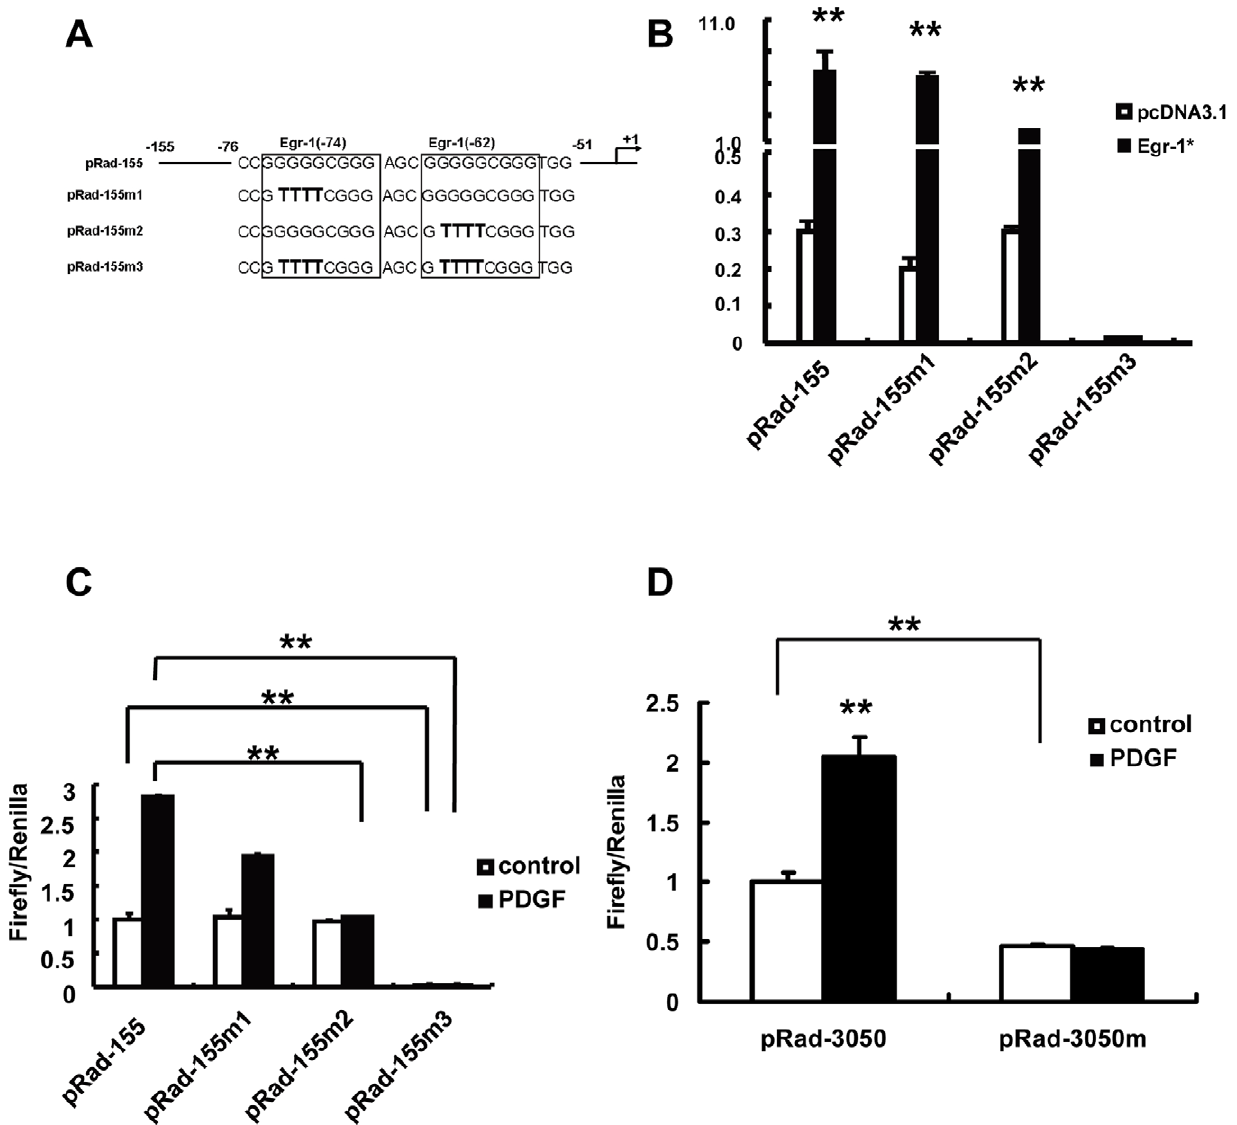
Figure 2. Egr-1 binding sites are essential for Rad promoter activation. (A) Nucleotide sequence between base pairs -76 and -51bp of Rad promoter. Egr-1 binding sites are boxed. The mutated bases are indicated in boldface. (B) Wild-type and mutant forms of pRad-155 were cotransfected with pcDNA3.1-Egr-1* or pcDNA3.1 into 293A cells and luciferase activity were determined. The fold induction of Lucifearse activity by Egr-1 was shown in the lower panel; (C) RASMCs were transfected with pRad-155 promoter reporter or its mutant forms then treated with PDGF and luciferase activity were determined (n=4, ** p , 0.01). (D) pRad-3050 and pRad-3050m were transfected into RASMCs then treated with PDGF and luciferase activity were determined (n=4, ** p ,